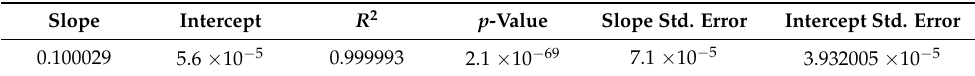
Figure 7. V-I relation for the shunt calibration with the multimeter. Table 4. Linear regression fit results for the shunt